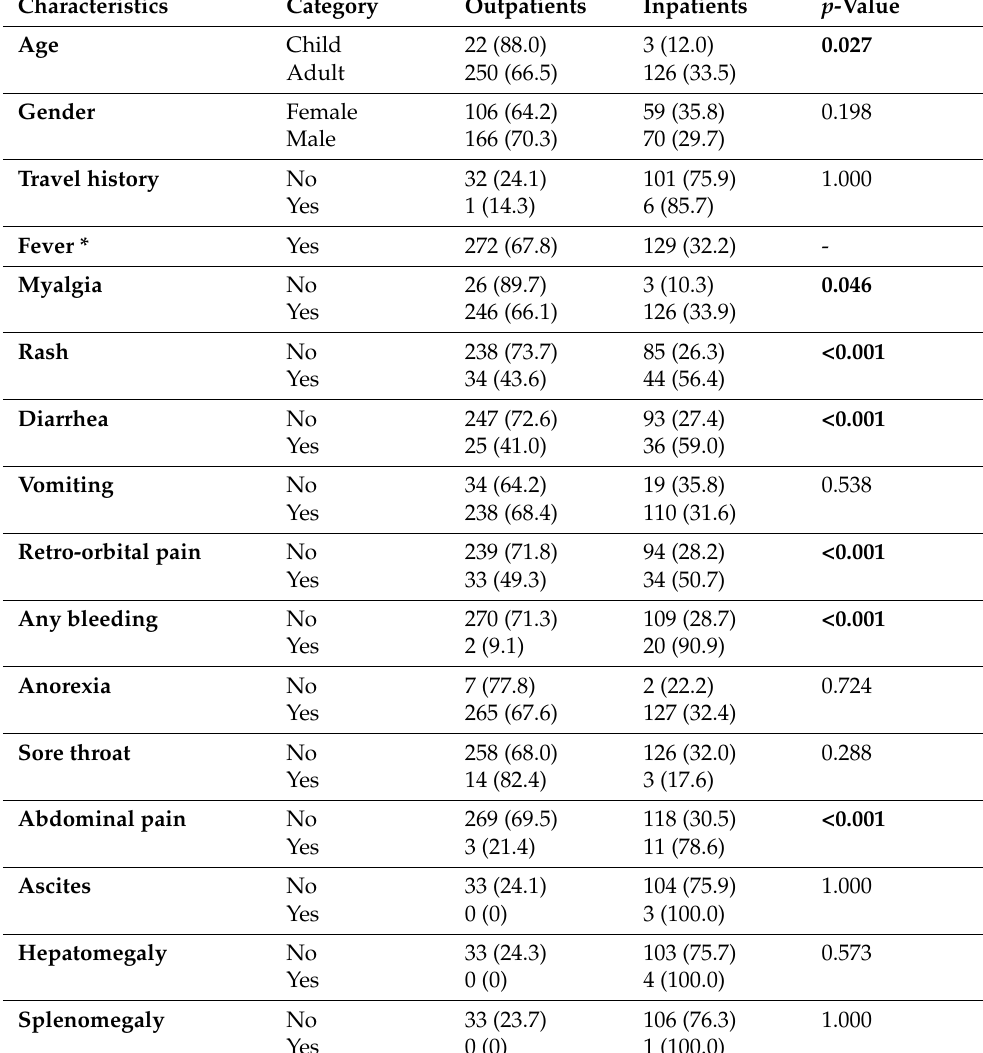
Table 1. Demographic and clinical characteristics of dengue patients, Nepal, 2022.